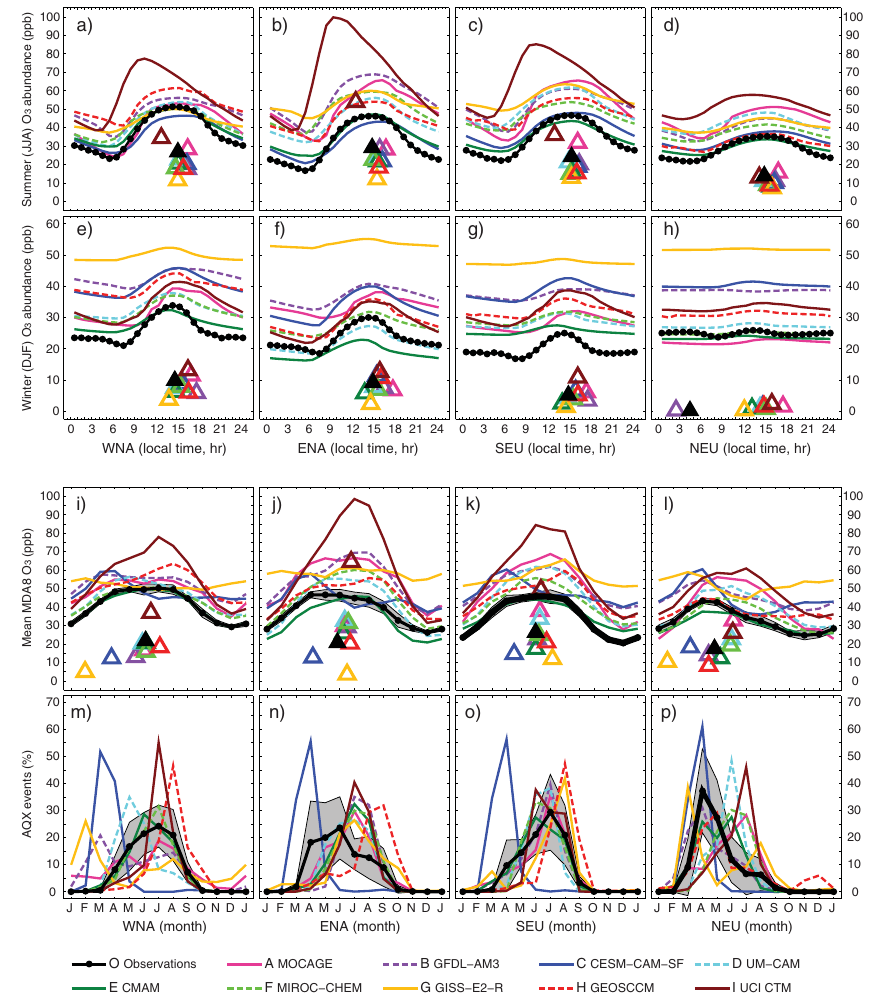
Figure 1. (a–h) Diurnal cycles of hourly O 3 abundances (ppb) for the observations (O), ACCMIP models (A–H), and UCI CTM (I) averaged over (a–d) summer (JJA) and (e–h) winter (DJF) months in ( a , e ) WNA, ( b , f ) ENA, ( c , g ) SEU, and ( d , h ) NEU. Triangles show the observation’s and models’ cosine fit derived values of the hour of maximum phase h and peak-to-peak amplitude H plotted as ( x , y ) = ( h , H ) for each season, region, observation, and model. ( i - p ) Annual cycles of ( i–l ) MDA8 O 3 and ( m–p ) AQX events in ( i , m ) WNA, ( j , n ) ENA, ( k , o ) SEU, and ( l , p ) NEU. The filled gray curve shows ± 1 σ for each month (calculated across years) for the observations. Triangles show the observations’ and models’ cosine fit derived values of the MDA8 cycle month of maximum phase m and peak-to-peak amplitude M plotted as ( x , y ) = ( m , M ) for each region, observation, and